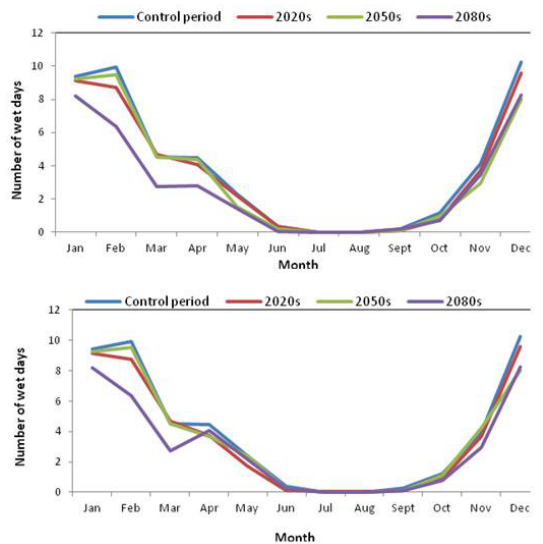
Figure 12. Average monthly wet days for A2 scenario (upper) and B2 scenario (lower) compared with control period.